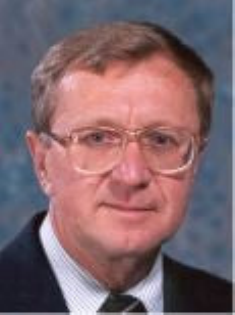
Figure 1. Professor Victor M. Starov.